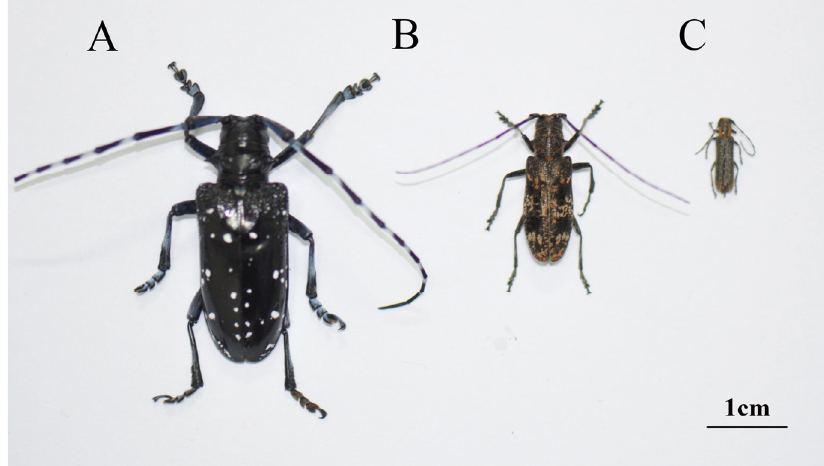
Figure 1. Images of three cerambycid beetle species. ( A ): Anoplophora chinensis , ( B ): Monochamus saltuarius , ( C ): Saperda populnea .